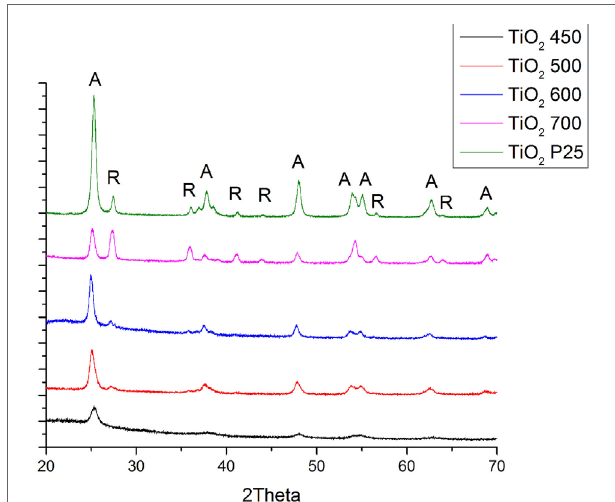
FigUre 3 | results XrD analyses of P25 and pure TiO 2 nanofibers annealed at different temperatures (a: anatase phase, r: rutile phase) .